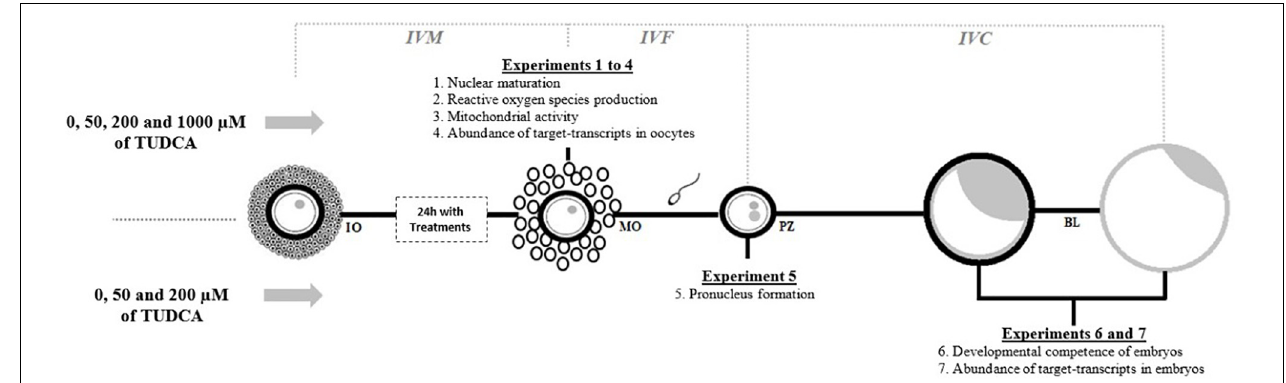
FIGURE 1 | Illustrative experimental design. IVM, in vitro maturation; IVF, in vitro fertilization; IVC, in vitro culture; IO, immature oocyte; MO, mature oocyte; PZ, presumptive zygote; BL, blastocyst and hatched blastocyst.